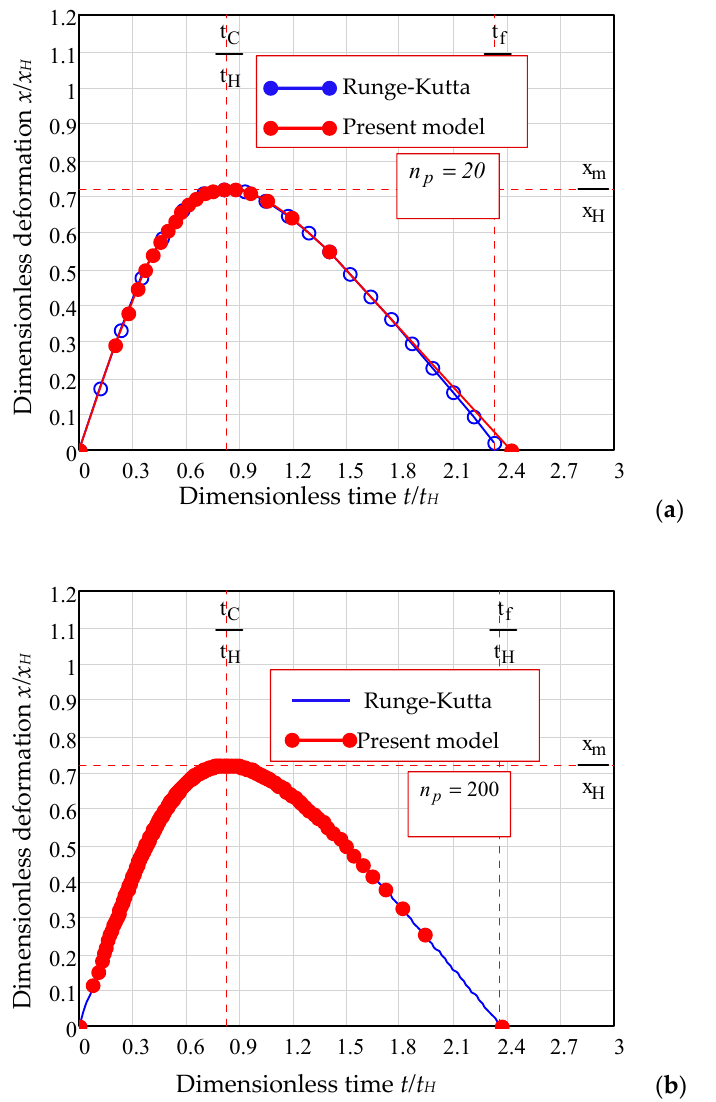
Figure 11. Comparison between the solutions of ODE obtained by proposed method and by Runge–Kutta algorithm: ( a ) n p = 20 and ( b ) n p = 200.